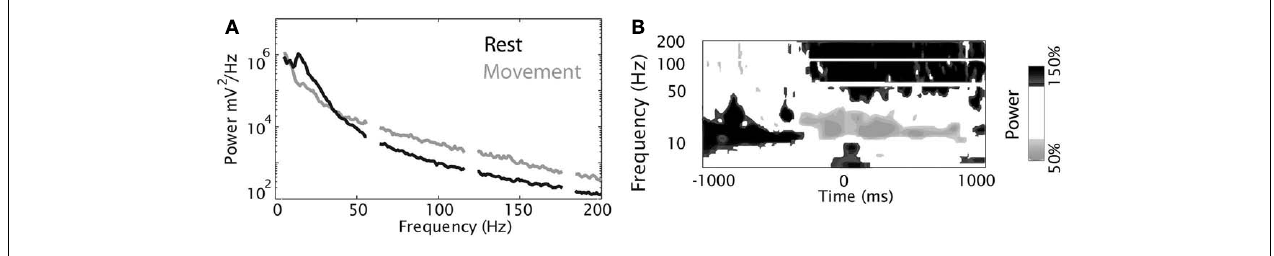
samples (light trace) and rest samples (black trace). (B) Average time-varying PSD (scaled as percentage of mean power at each frequency) with respect to first index finger movement from each movement cue.